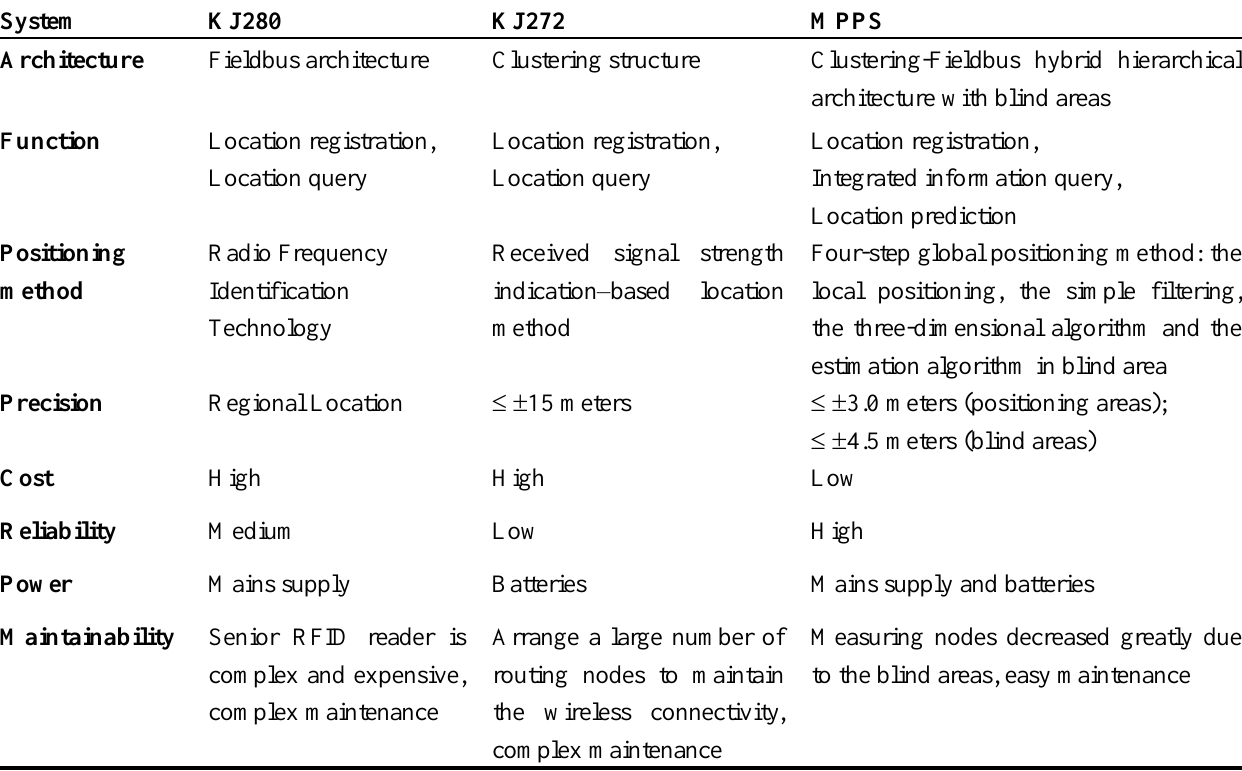
Table 10. The comparison between KJ280, KJ272 and MPPS positioning